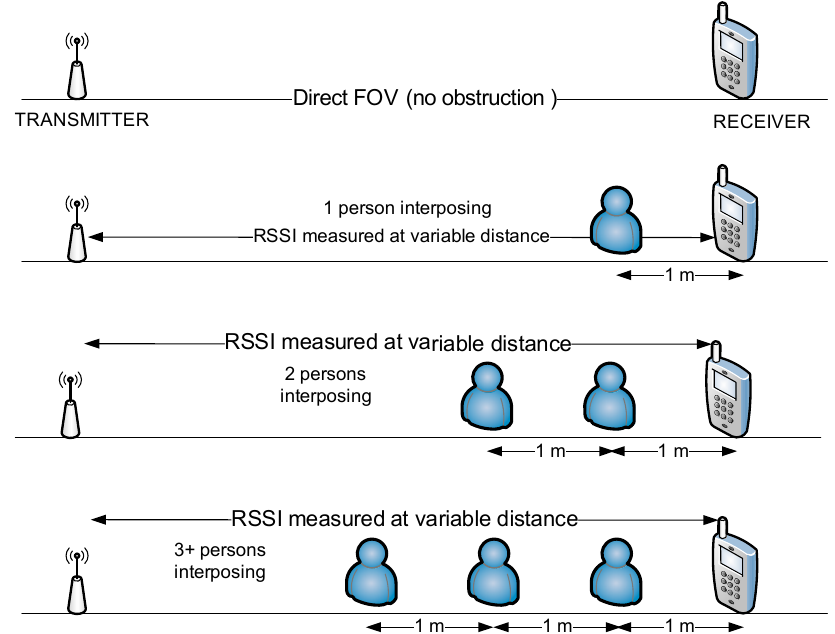
Figure 16. Successive positioning of interposing human bodies between the transmitter and the receiver, FOV line.